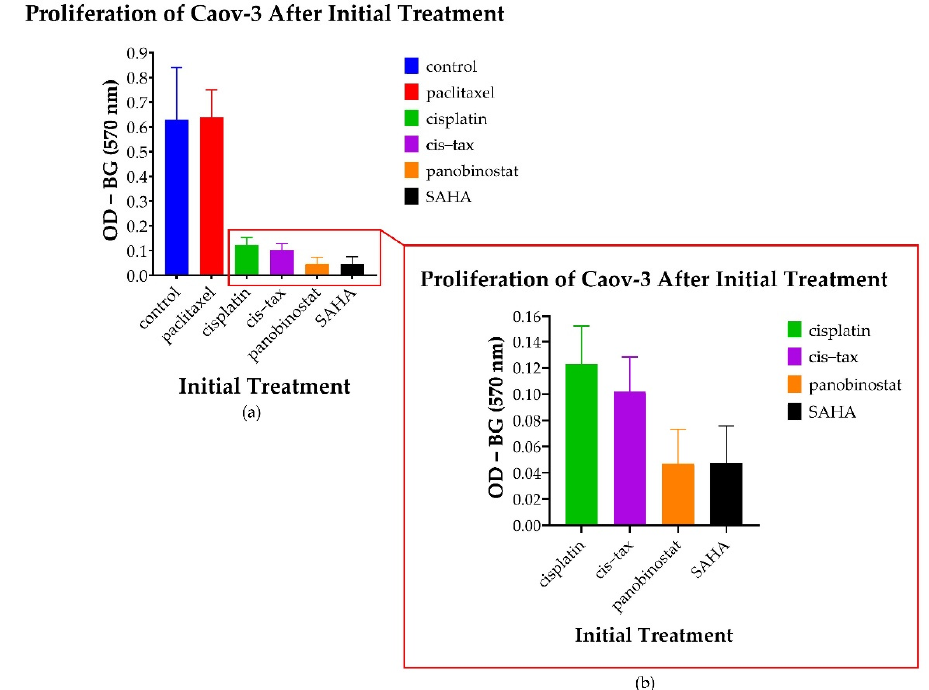
Figure 9. Changes in the proliferation of 3D-derived cells following various treatments. Cells derived from Caov-3 spheroids pretreated with a DMSO control, paclitaxel, cisplatin, cisplatin–paclitaxel and panobinostat were allowed to regrow for 7 days. Optical density (OD) was measured at 570 nm minus the background (BG). ( a ) Cells treated with paclitaxel demonstrated regrowth almost to the level of the control ( p < 0.001). ( b ) Cells pretreated with panobinostat and SAHA demonstrated the sustained inhibition of proliferation of Caov-3 spheroid-derived cells as compared to the control ( p < 0.001) ( n = 8).